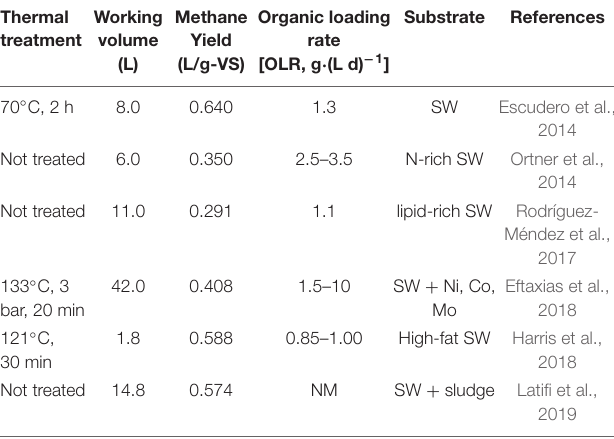
Thermal treatment